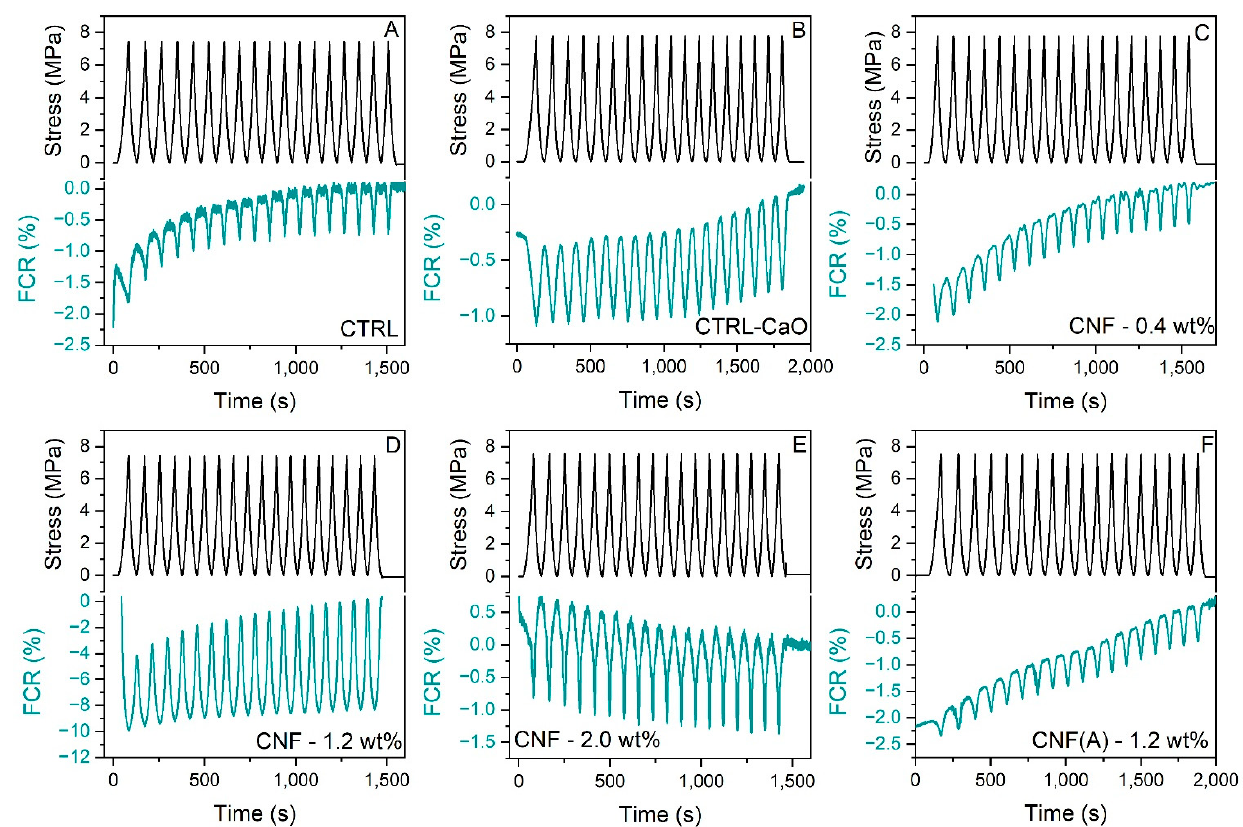
Figure 9. Piezoresistive behaviours of mortars under cyclic compressive loading. ( A ) Control mortar; ( B ) control mortar with CaO substrate; ( C ) mortar with 0.4 wt% of CNF; ( D ) mortar with 1.2 wt% CNF; ( E ) mortar with 2.0 wt%; ( F ) mortar with 1.2 wt% washed CNF.